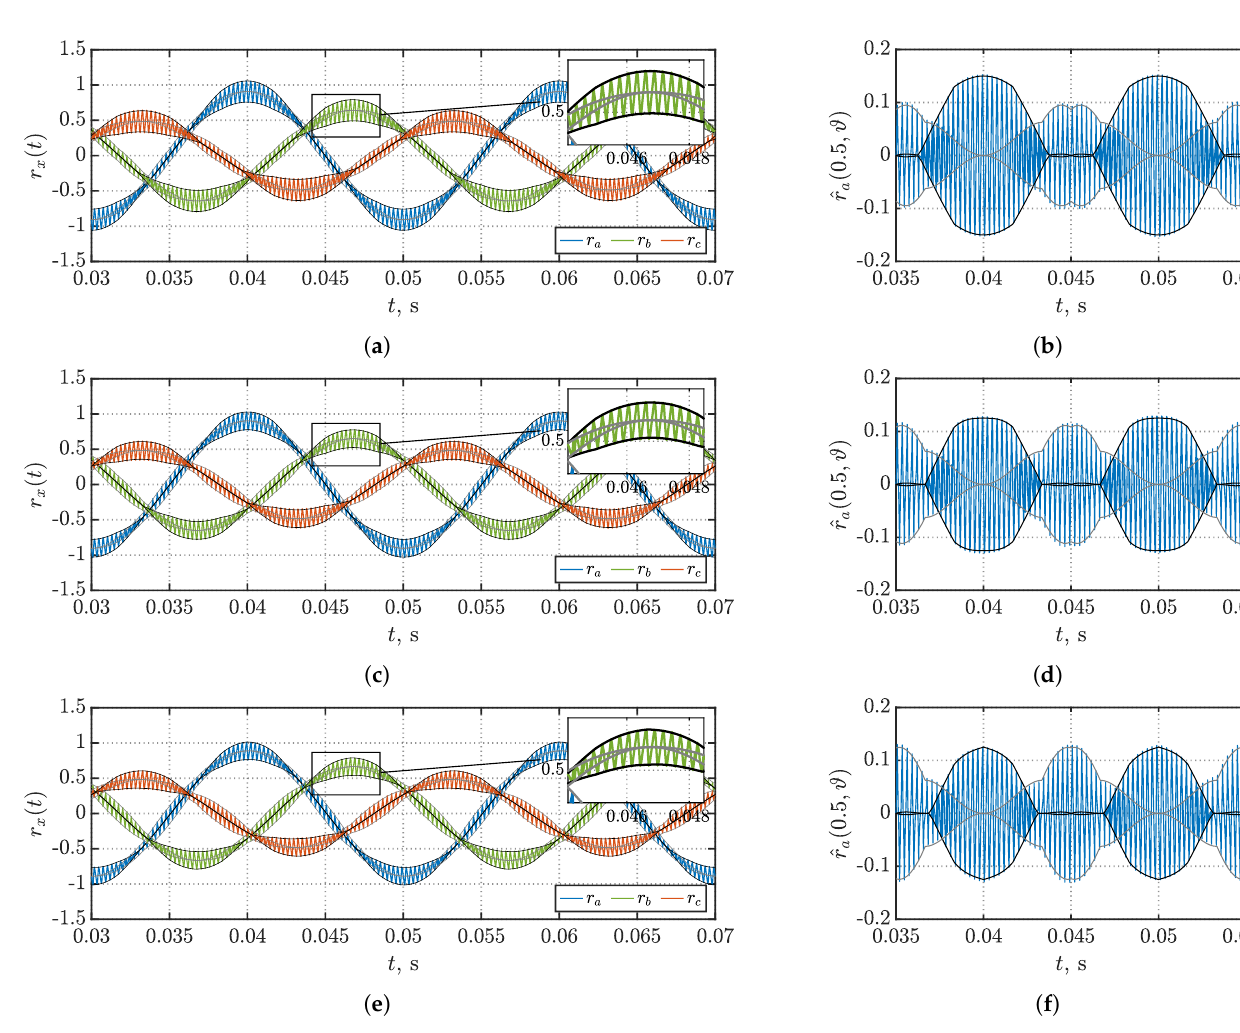
Figure 4. Normalized unbalanced phase currents along with their primary (black) and secondary (gray) current rip- ple envelopes ( a , c , e ) m = 0.5 and corresponding normalized switching current ripples in phase a with their respec- tive primary (black) and secondary (gray) envelopes, ( b , d , f ) k = 0.5 (upper plots ( a , b )), k = 1 (middle plots ( c , d )), and k = 2 (bottom plots ( e , f )). Table 1. System parameters.